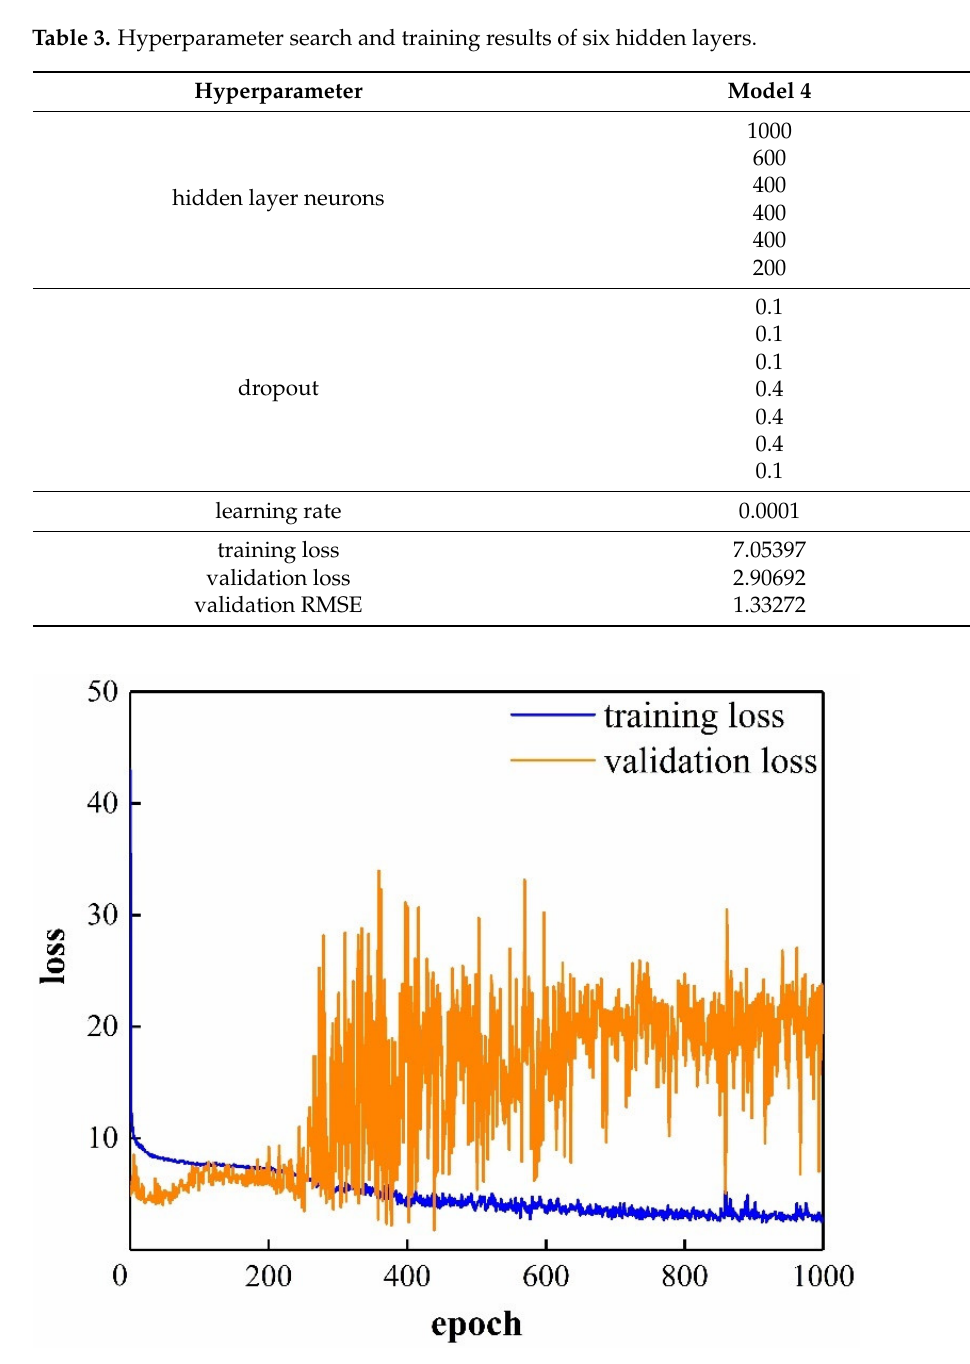
Table 3. Hyperparameter search and training results of six hidden layers.